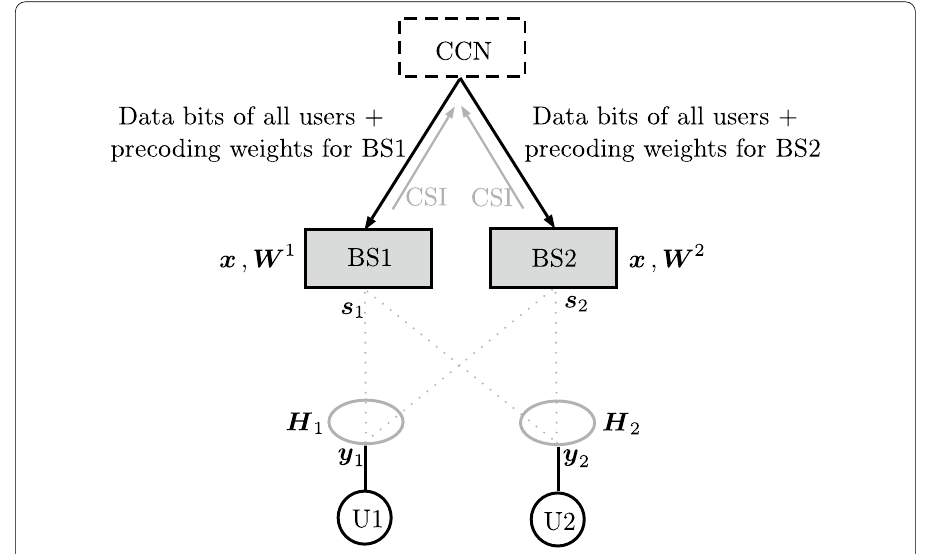
Fig. 2 Downlink transmission setup in a JT-CoMP